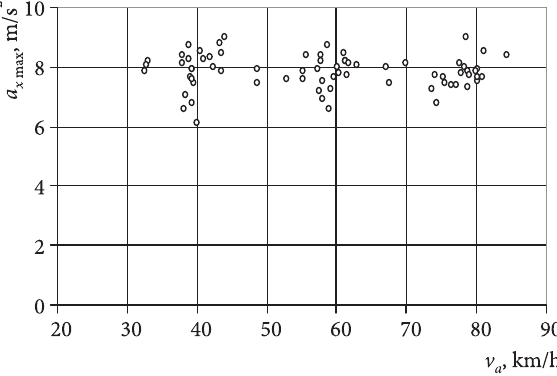
Fig. 5. Th e scatter of a values for cars without x max